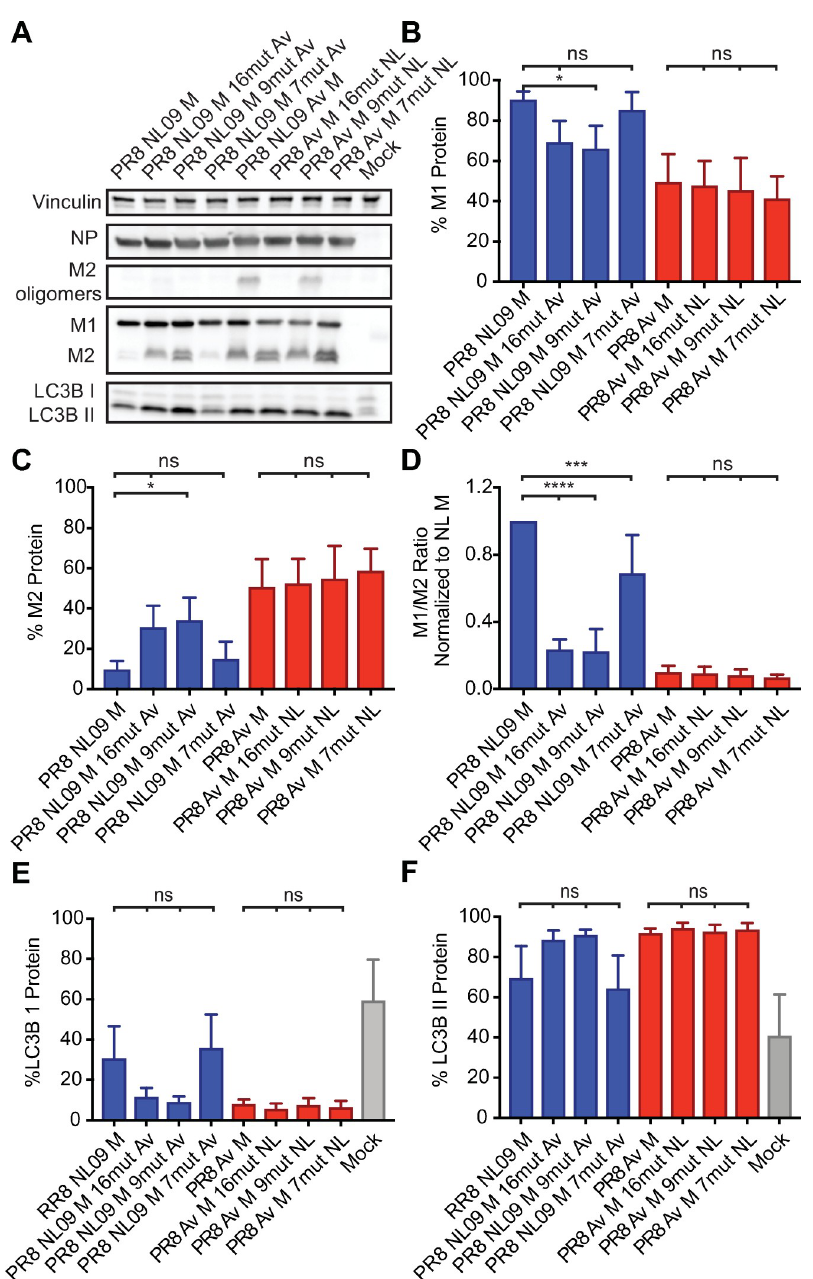
Fig 13. Activation of LC3B II correlates with high expression of M2 protein in A549 cells regardless of M2 amino acid composition. PR8 NL09 M virus and PR8 avian M virus, along with six chimeric variant PR8-based viruses, were inoculated at a MOI of 5 PFU/cell onto A549 cells. Cells were incubated for 8 h, then lysed. (A) Western immunoblot analysis of virus-infected A549 cells. Vinculin was measured to allow normalization of viral protein levels. NP was measured to assess viral replication. Levels of M1 and M2 protein were assessed using an antibody (Mab E10) to a common epitope at the amino terminus of M1 and M2 proteins, allowing their direct comparison. Levels of LC3B I and II were assessed using an antibody that detects both the precursor and activated forms of LC3B protein. (B) M1 protein and (C) M2 protein were normalized to vinculin and displayed as a percentage of total protein expressed from the M gene. (D) The ratio of M1:M2 protein expression. (E) LC3B I protein and (F) LC3B II protein were normalized to vinculin and displayed as a percentage of total LC3B protein. Graphs in B-F show the means with SD from three independent experiments. For each experiment, two replicate Western immunoblots were performed and quantitated. Statistical significance was assessed using ordinary one-way ANOVA.